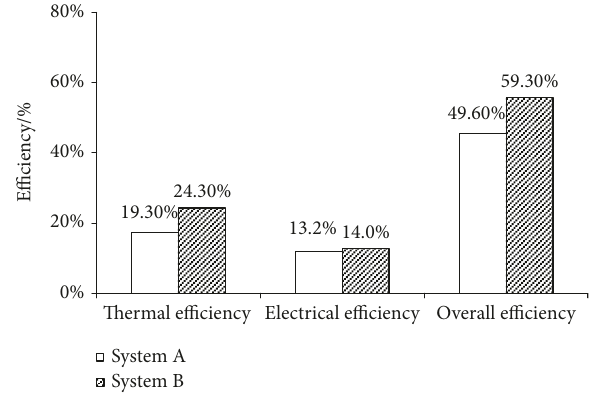
Figure 12: Comparison of daily average e ffi